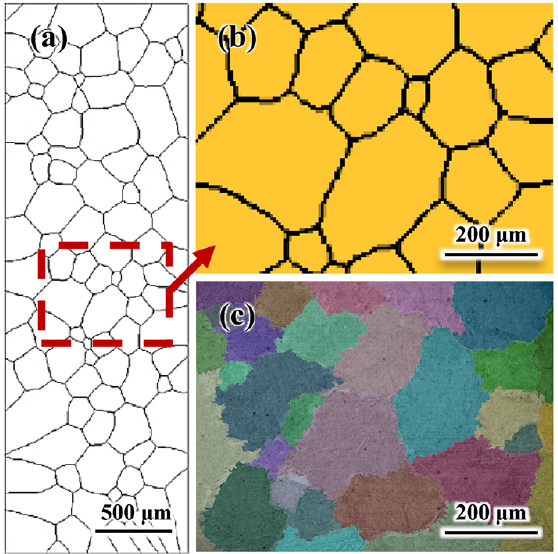
Figure 1. Initial grain structure before hot-rolling: ( a ) initial microstructure generated for the CA simulations; ( b ) enlarged microstructure in the region of the box in ( a ); ( c ) micrograph of the wa- ter-quenched sample cut from a slab after annealing at 1150 °C for 2 h before